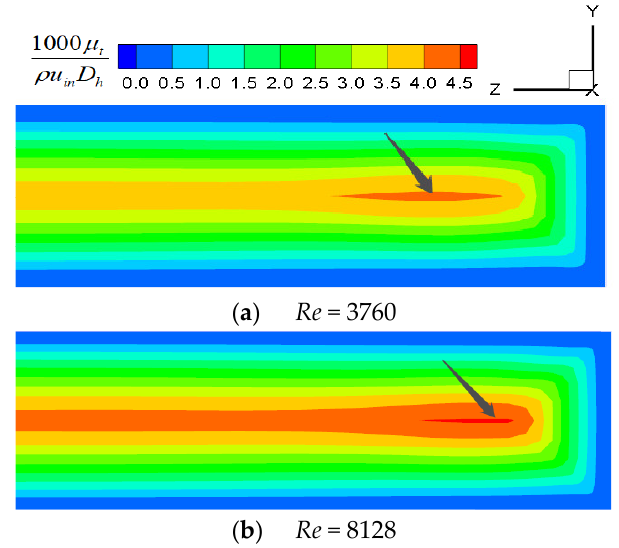
Figure 19. Nondimensional eddy viscosity contours on the middle cross section.